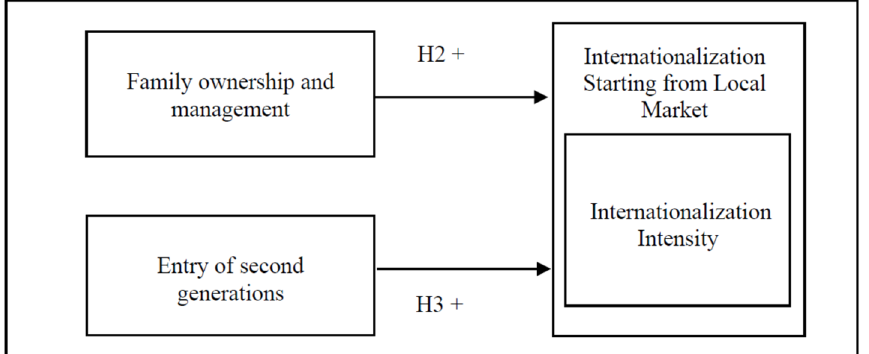
Figure 2. Research Model. Internationalization Starting from Local Market.